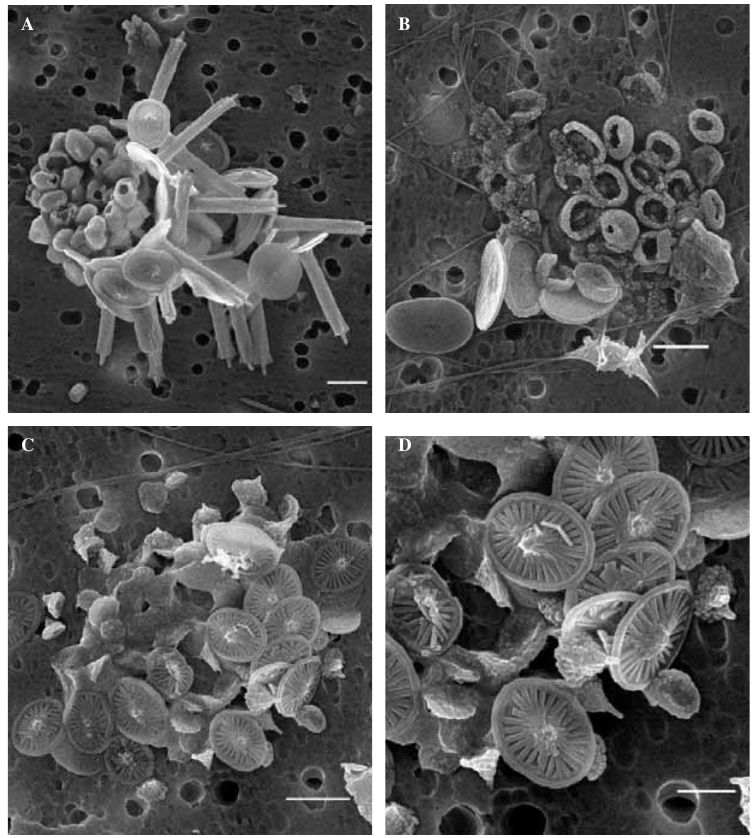
of Fig. C. Scale bars: A, B, C = 2 μm; D = 1